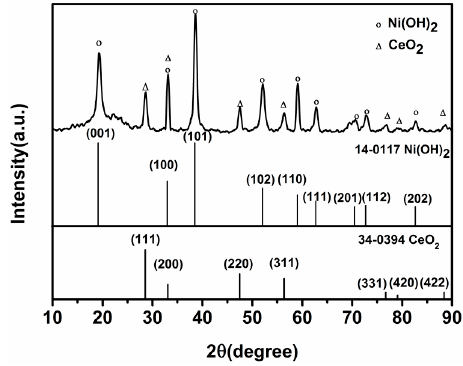
Figure 2. XRD patterns of CeO 2 /Ni(OH) 2 nanocomposite (Ce:Ni = 0.05:1).